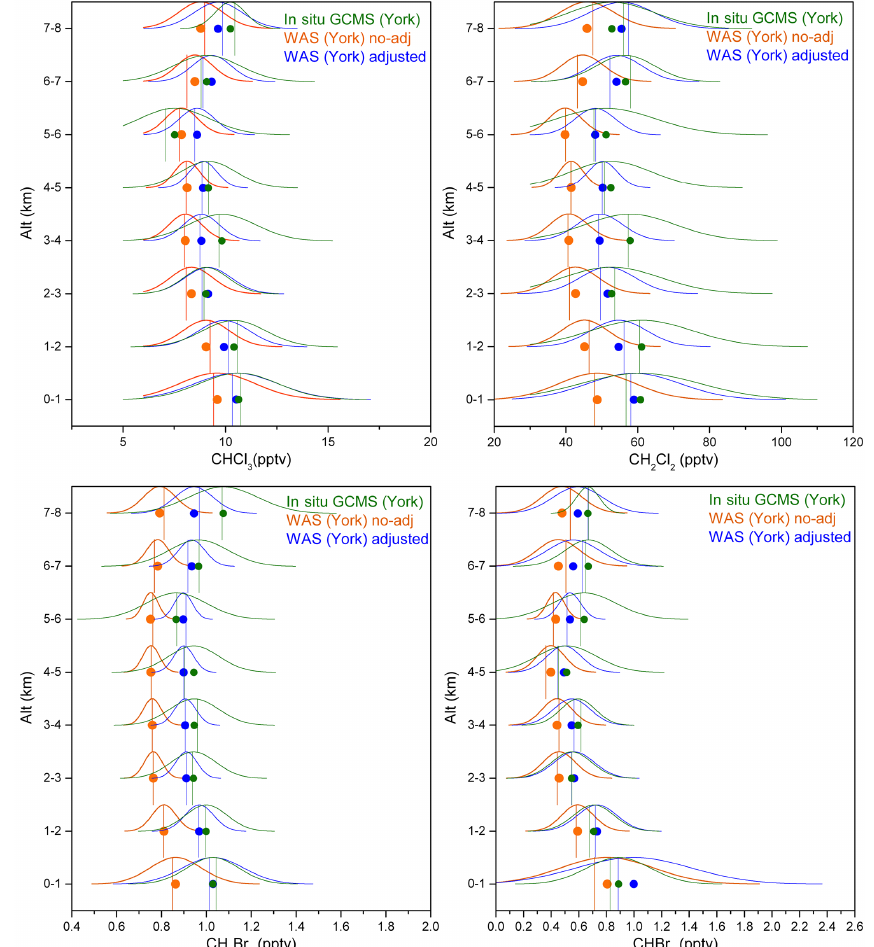
Figure 4. Vertical profile distribution bins showing a comparison of raw WAS data (orange), in situ data (green) and WAS data adjusted to in situ data via the method described in the text